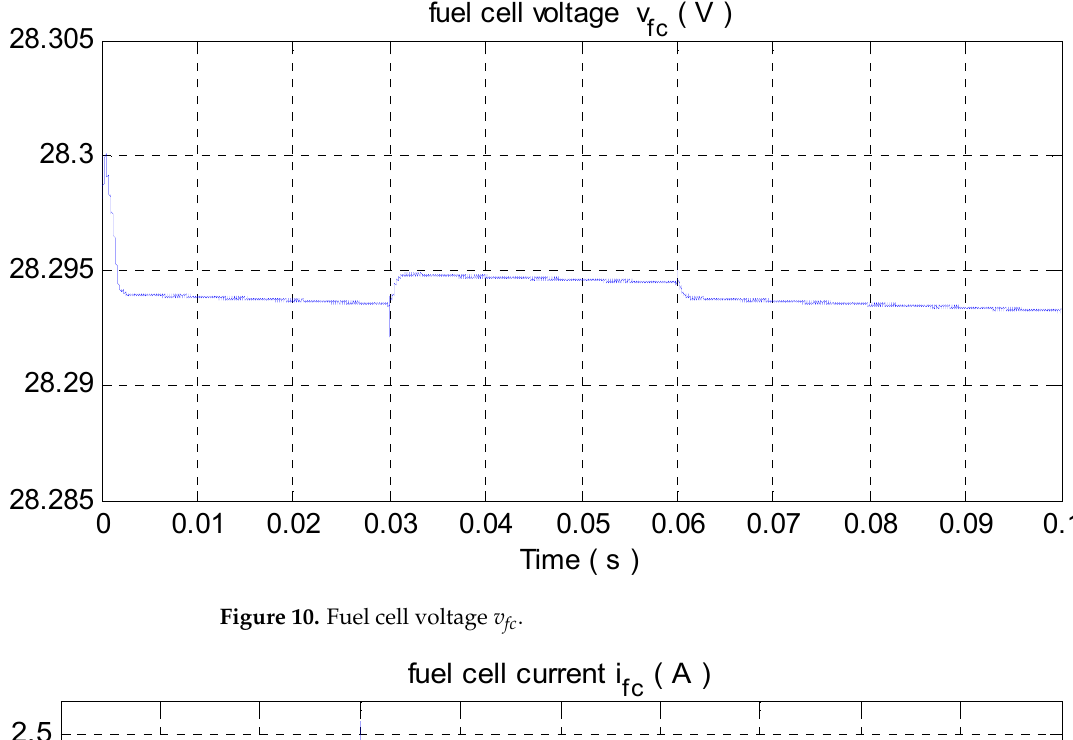
Figure 9. Estimate unknown parameter 𝜃 and its reference.